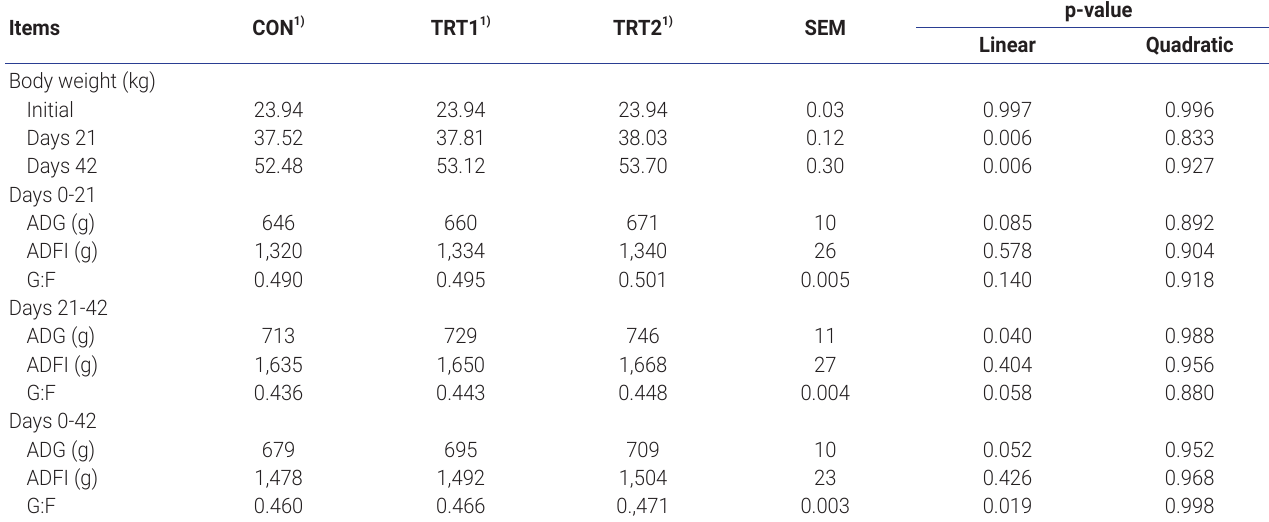
Table 2. Effect of dietary supplementation Achyranthes japonica extracts on growth performance in growing pigs Items